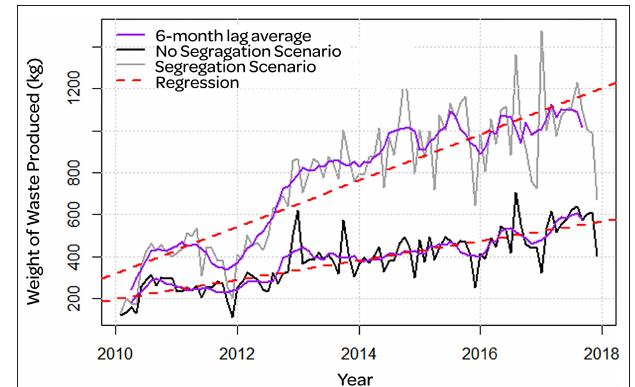
FIGURE 2 | Amount of waste produced that was not incinerated (gray line) and which was incinerated (black line). Moving averages filter with 6 months lag (purple line) and regression line (red dashed line).